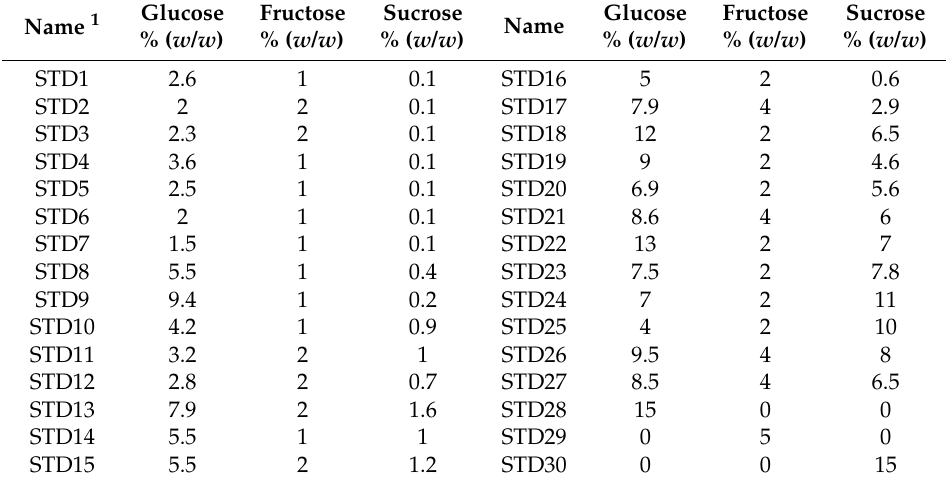
Table 2. Concentrations of carbohydrate standard solutions set (concentrations of glucose 0–15%; fructose 0–5%; sucrose